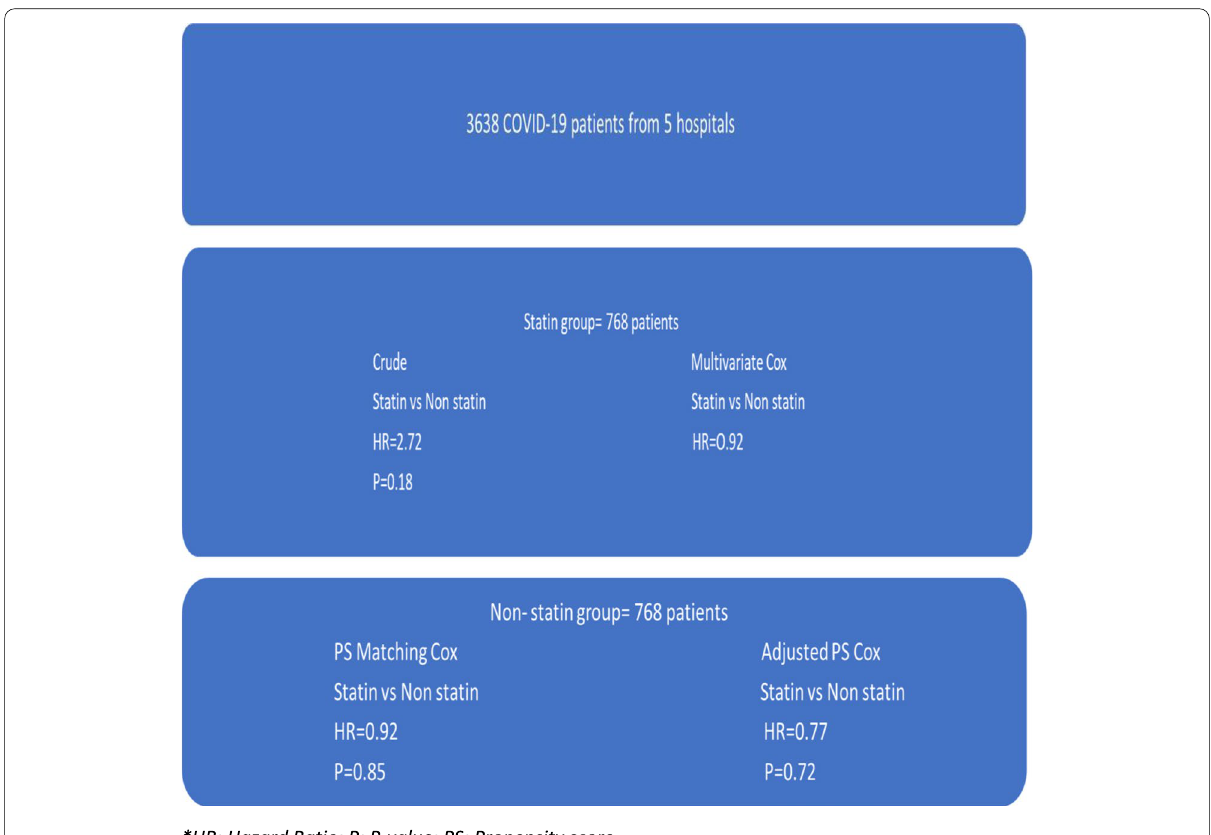
Fig. 1 Cox proportional-hazards regression scores in the cohort study pools. *HR: Hazard Ratio; P: P -value; PS: Propensity